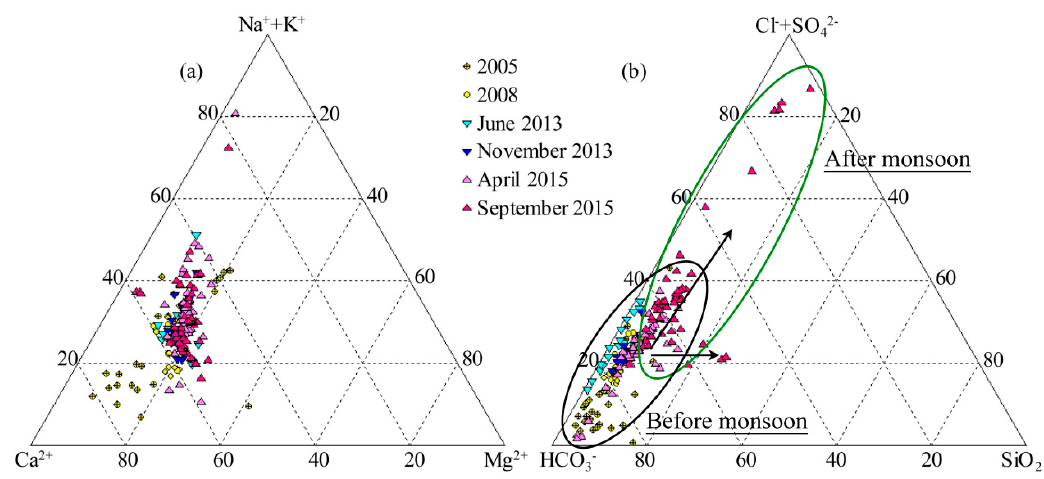
Figure 3. Ternary diagrams showing the relative abundances of ( a ) cations and ( b ) anions on a molar basis.